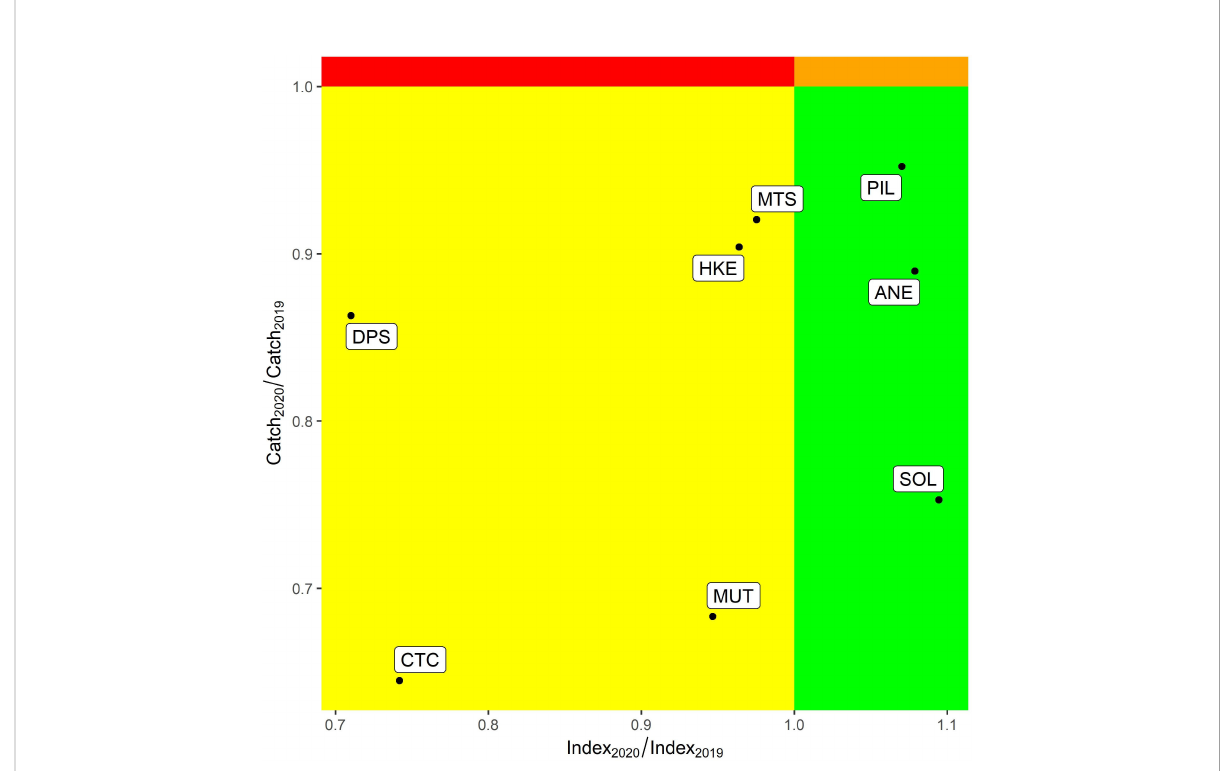
FIGURE 2 Kobe plot with ratio of catches (C) and biomass indexes (I) in 2020 and 2019 of the eight Adriatic Sea target stocks.